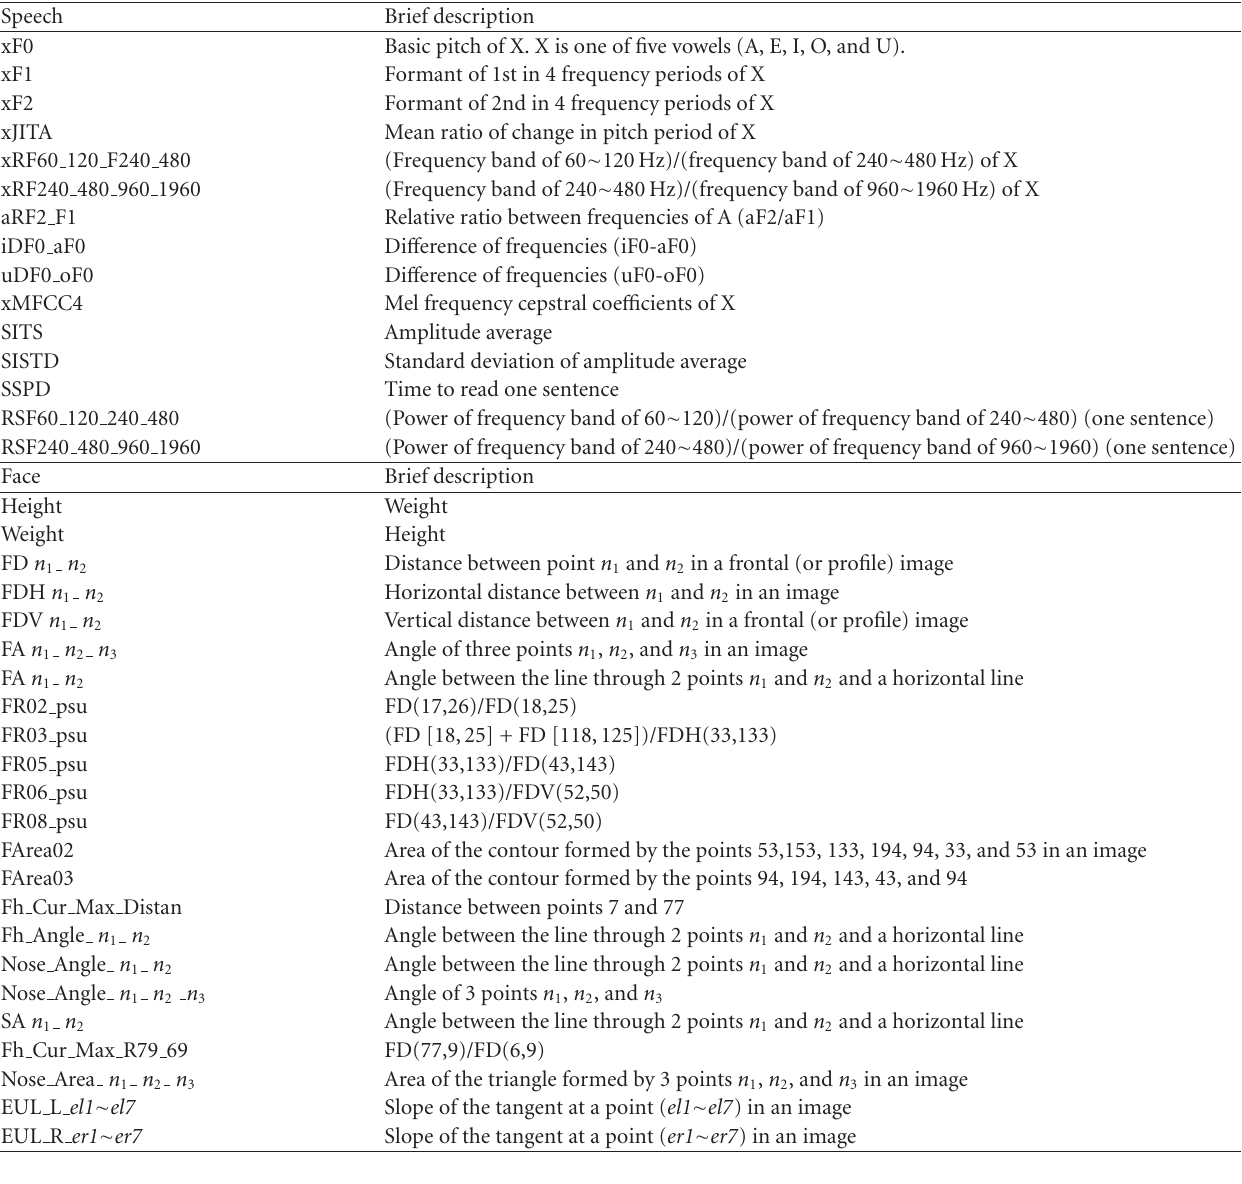
Table 1: All features used in this study and brief